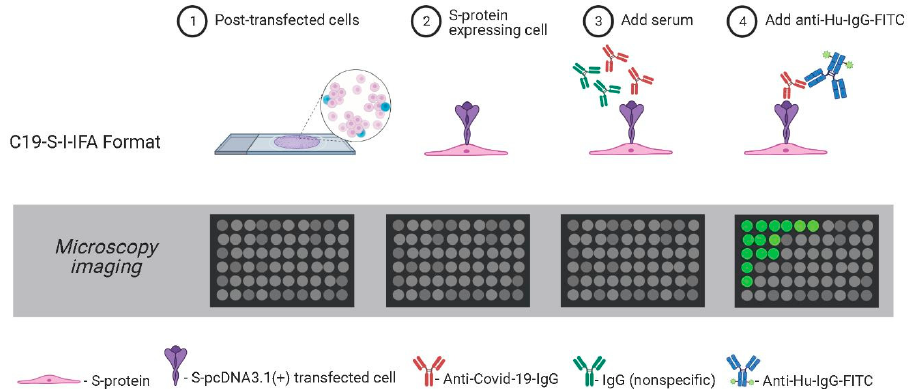
Figure 1. Schematic of the C19-S-I-IFA assay. Serum samples were added to A549-SARS-CoV-2-spike expressing cells. Bound anti-COVID-19-IgG were detected with anti-human-IgG-FITC. Positive cells were indicative of virus-infected sera.